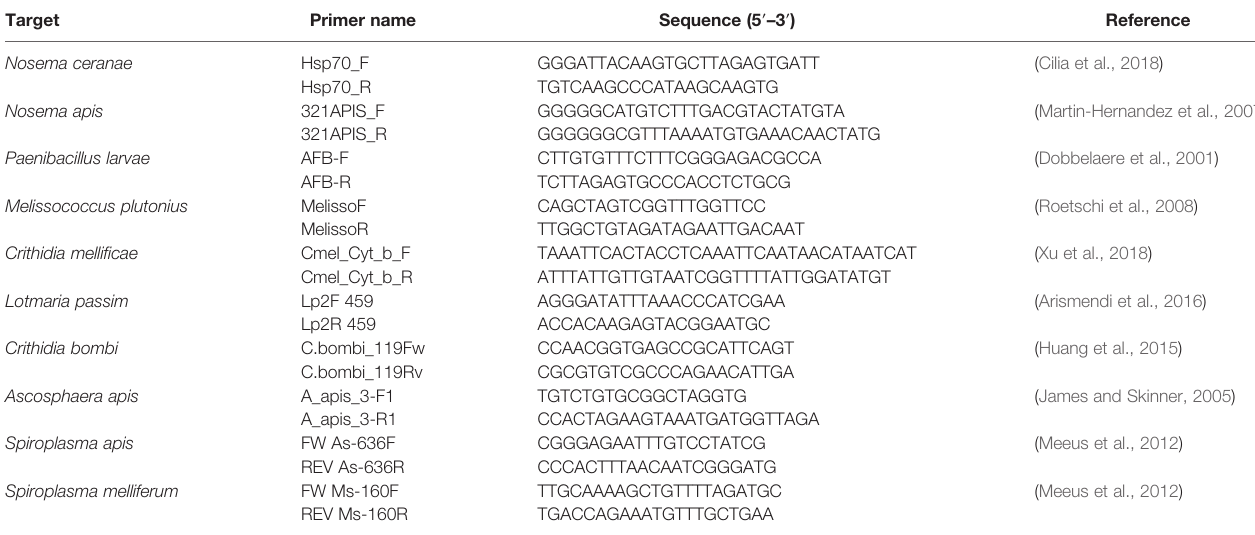
TABLE 2 | List of primers used to detect fungi, bacteria, and